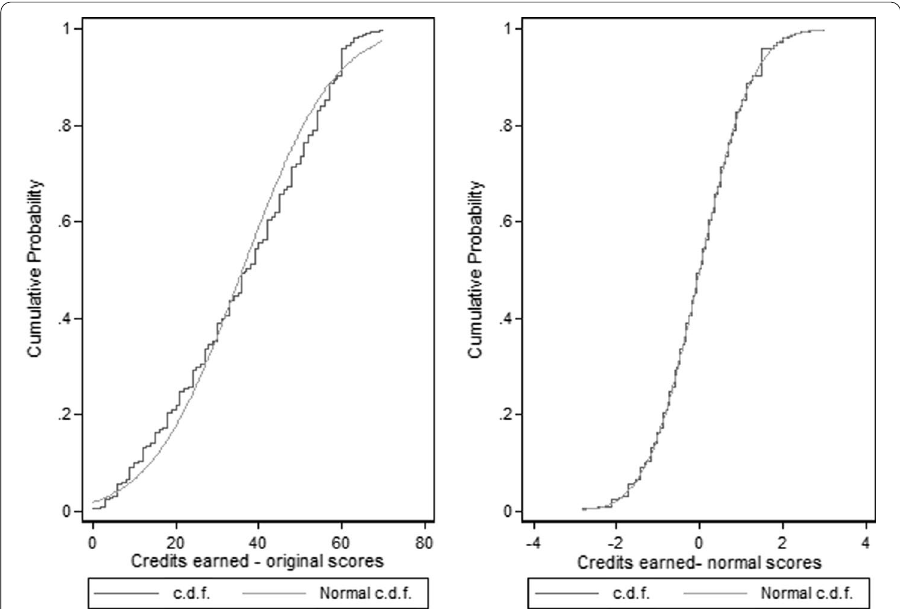
Fig. 1 Normal score transformation of credits earned during the first year of enrolment